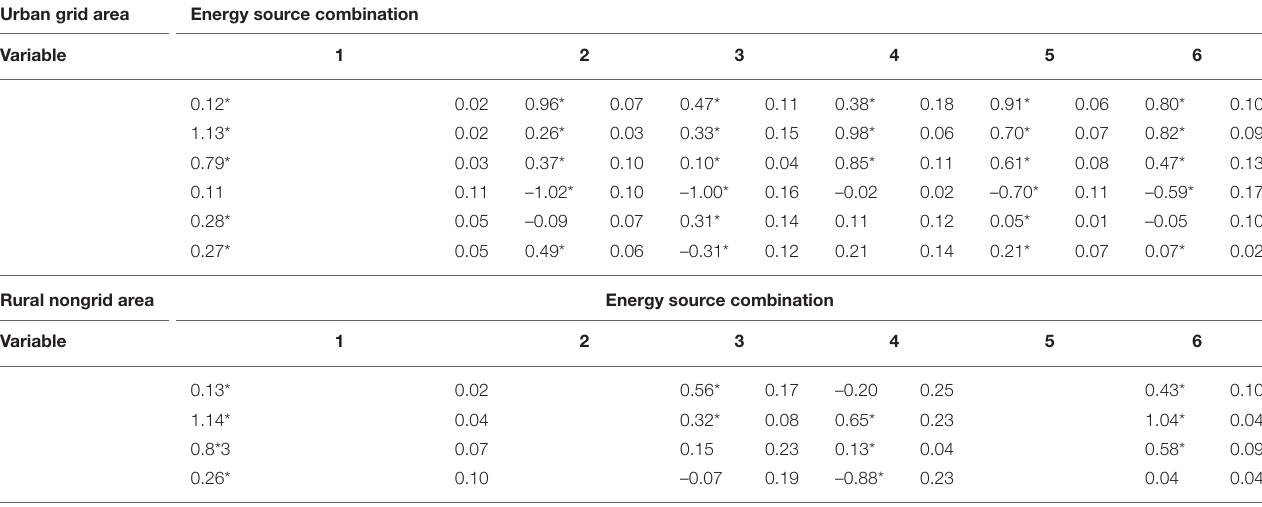
TABLE A | Matrix of correlation